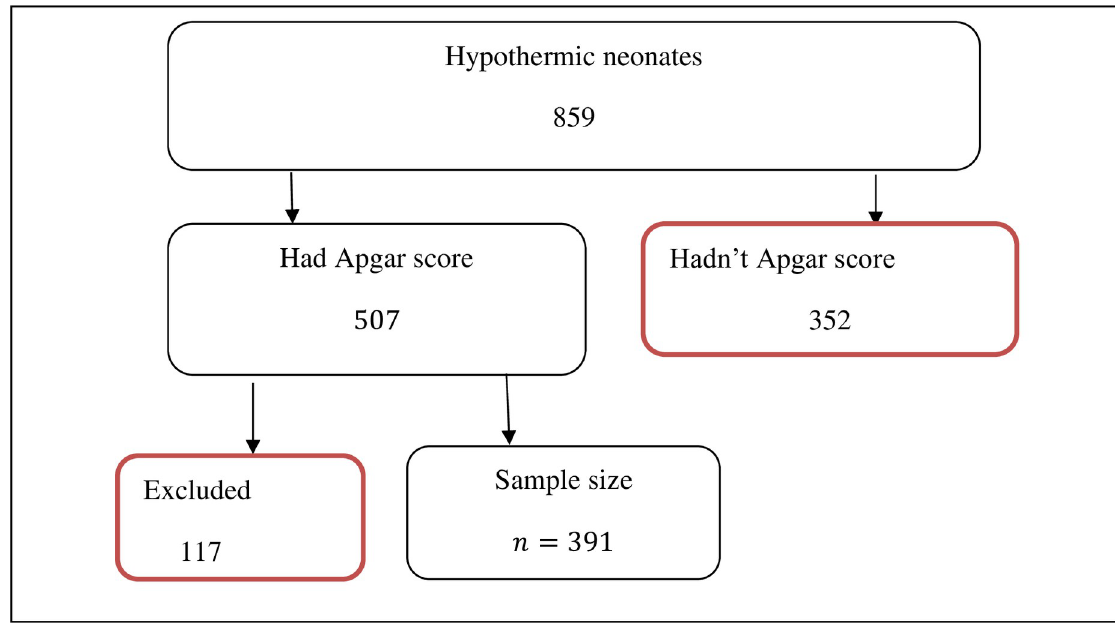
Fig 1. The conceptual framework of sampling